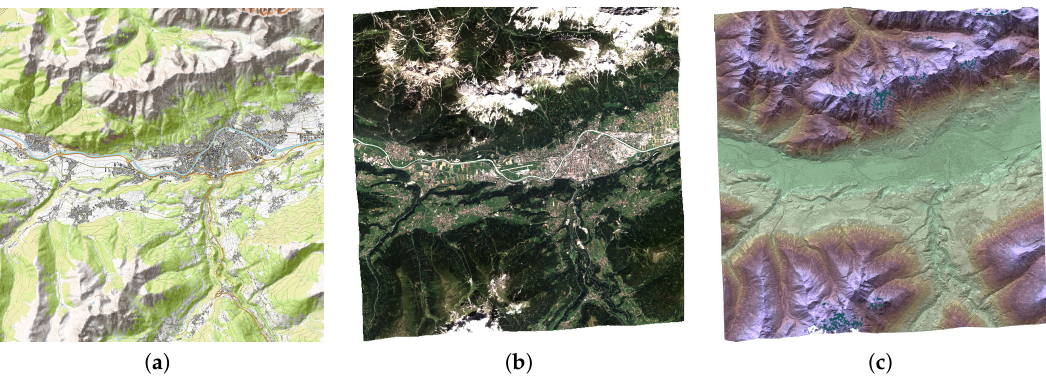
Figure 3. The test site Innsbruck (Austria): ( a ) topographic map (opentopomap.org (CC-BY-SA)), ( b ) RGB ortho-image and ( c ) relief shaded DSM. ( b , c ) were produced employing the proposed and implemented mapping workflow.